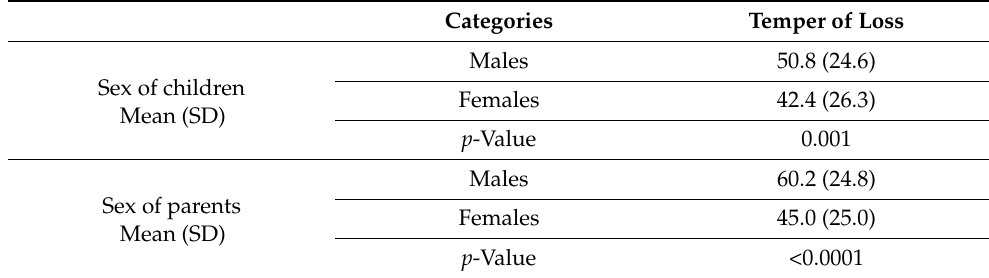
Table 5. Differences in sociodemographic characteristics and study’s measurements in the subscale of the MAP-DB